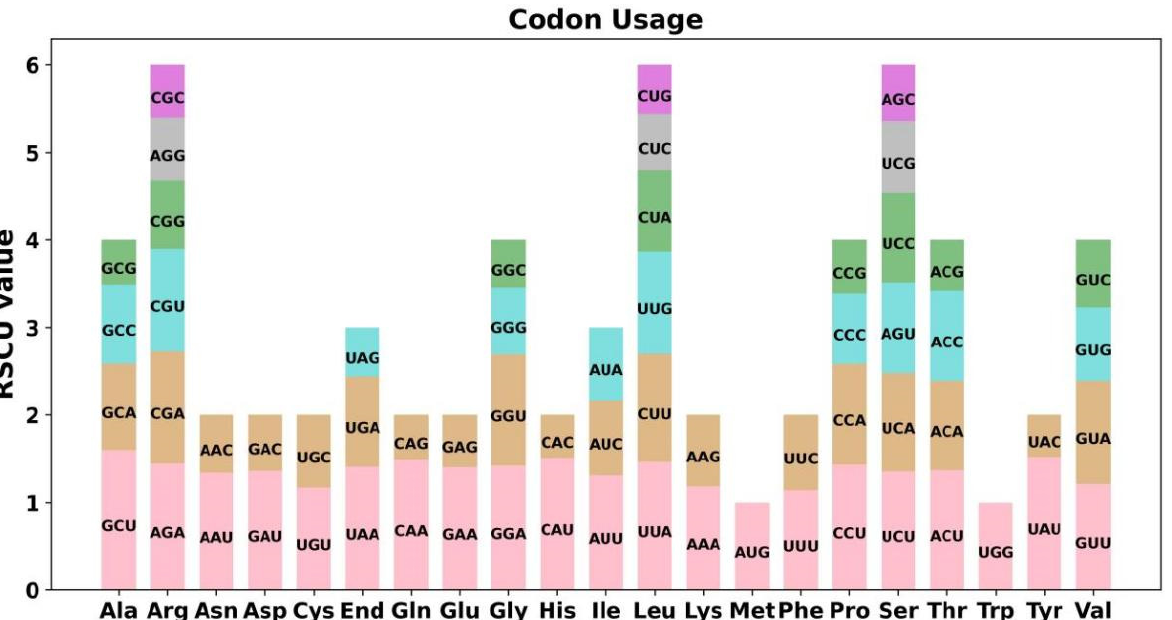
Figure 3. Q. acutissima mitogenome relative synonymous codon usage (RSCU). Codon families are shown on the x -axis. RSCU values are the number of times a particular codon is observed relative to the number of times that codon would be expected for a uniform synonymous codon usage.